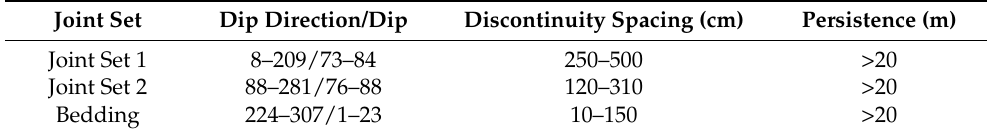
Figure 9. Three ‐ dimensional HR Point Cloud of the Raspadalica Cliff with extracted facets using the Cloud Compare Facet plugin [43,61] (Fast Marching procedure). Orange and red to cyan facets repre ‐ sent Joint Set 1, parallel with the cliff face; green to yellow facets represent Joint Set 2, almost or ‐ Table 2. Values of orientations, discontinuity set spacing, and persistence obtained by remote sensing thogonal to Joint Set 1; and blue facets represent Joint Set 3 (bedding). survey and